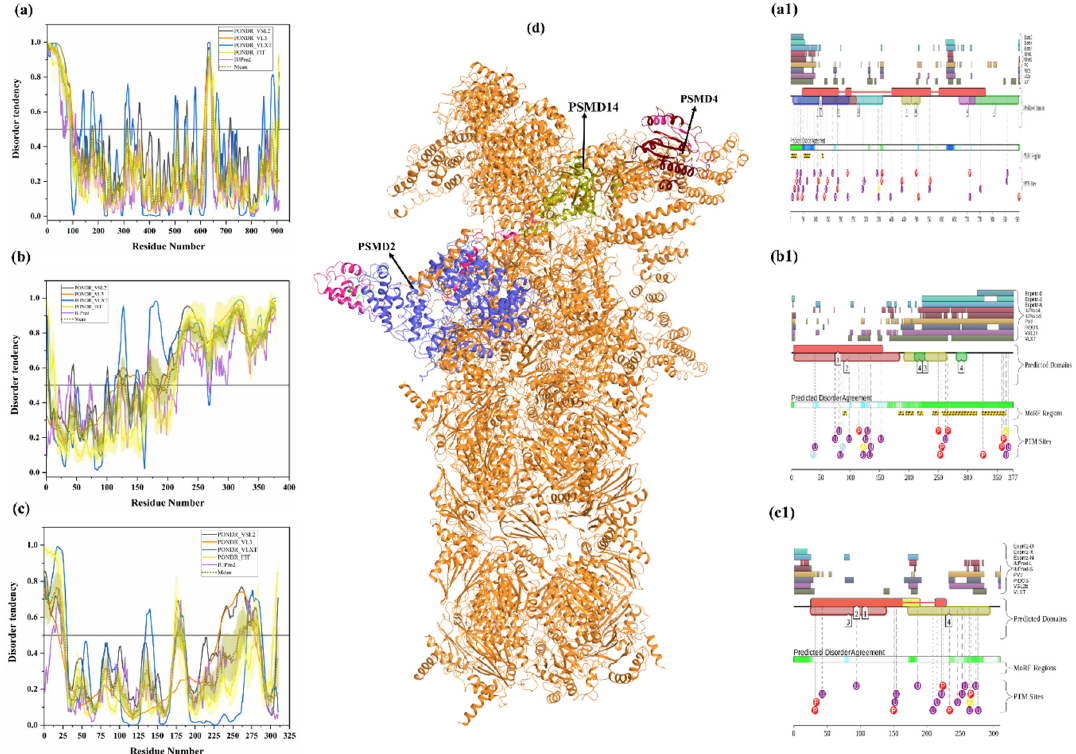
Figure 11. Intrinsic disorder predisposition of human PSMD2 ( a ), PSMD4 ( b ), and PSMD14 ( c ). Plots show the intrinsic disorder profile generated by a set of per-residue disorder predictors, such as PONDR ® VSL2, PONDR ® VL3, PONDR ® VLXT, PONDR ® FIT, and IUPred. The corresponding outputs are depicted by black, orange, blue, yellow, and purple curves respectively. Mean disorder profile is calculated from the average of five predictor-specific per-residue disorder profiles and shown by the olive color curve. Predicted disorder scores above 0.5 are considered disordered residues/regions. Light-olive shadow around the mean curve represents the error distribution for the mean. The light-yellow shadow around the PONDR ® FIT curve shows the error distribution for that predictor. ( d ) portrays the cryo-EM structures of substrate-engaged human 26S proteasome in seven different conformational states (PDB ID: 6MSB); all three reported proteins PSMD2 (blue), PSMD4 (wine) and PSMD14 (olive) are shown in this complex. D2P2 server-based functional disorder profiles are shown in ( a1 , b1 , c1) .